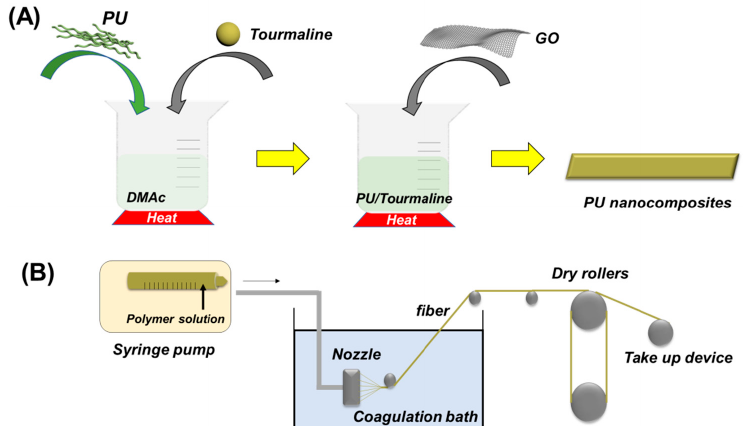
Figure 2. Preparation of the PU nanocomposite fibers: ( A ) preparation of the PU nanocomposite and ( B ) wet spinning process. ( B ) wet spinning